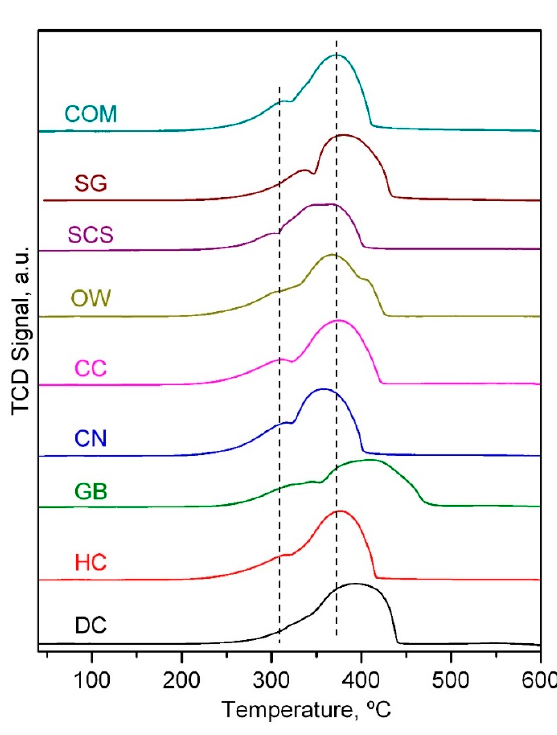
Figure 5. H 2 -TPR profiles of the bulk Co 3 O 4 catalysts.